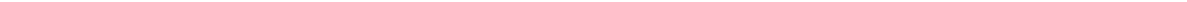
Fig. 4 Treatment with BDPP promotes fear memory recall through upregulation of c-Fos. a Training scheme. After recovery from surgery, mice are treated with BDPP or vehicle for 2 w prior to training in CFC. b Increase in freezing upon light stimulation in Habituation and Recall sessions for mice injected with AAV 9 -TRE-ChR2-mCherry. Untreated and BDPP-treated mice both show an increase in freezing behavior in the Recall session, but the increase is greater in mice treated with BDPP. Recapitulation of freezing is normalized to the increase in freezing in the light-on period of the Habituation session (100%; one- way ANOVA, n = 11 per group). c Number of neurons in the DG of hippocampal sections from untreated and BDPP-treated mice expressing c-Fos and ChR2-mCherry (one-way ANOVA, n = 4,8 per group). d Increase in freezing upon light stimulation in Habituation and Recall sessions for mice